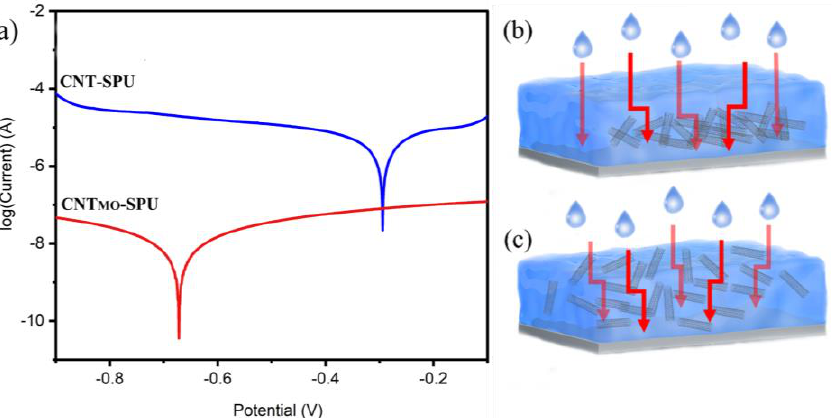
Figure 10. Potentiodynamic polarization curves ( a ), anticorrosion schematics ( b , c ) of CNT-SPU coating and CNT MO -SPU coating . Table 3. Results of potentiodynamic polarization test for different coatings.